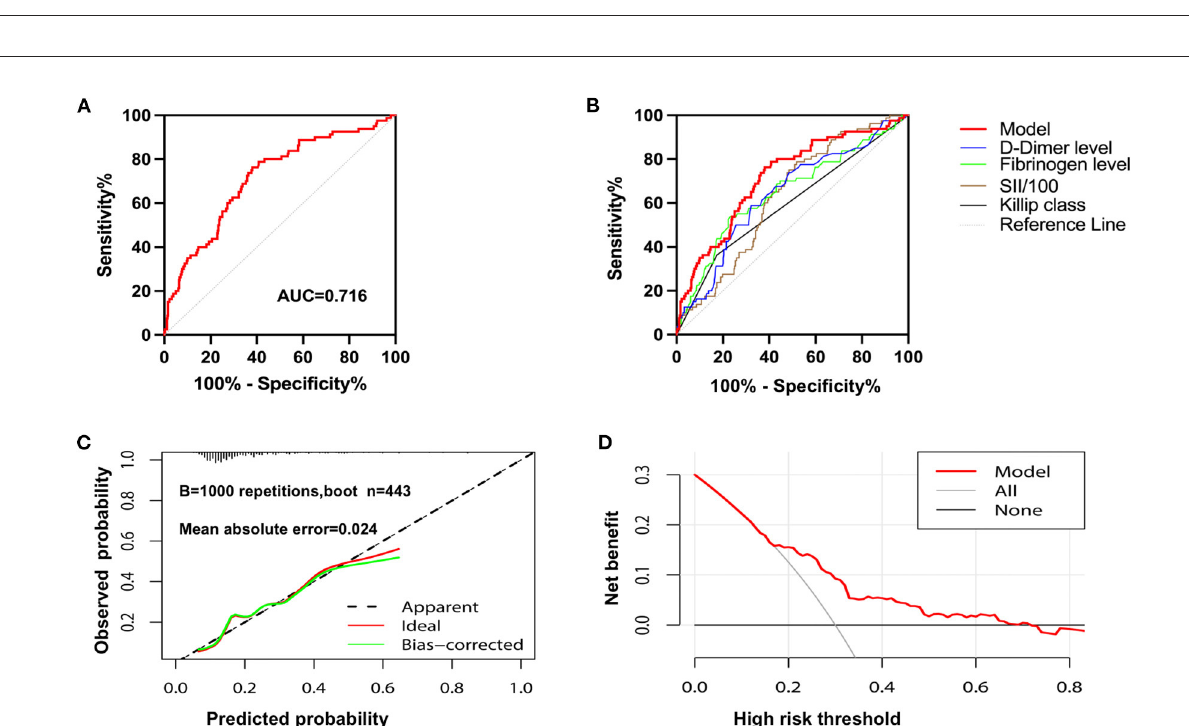
FIGURE3 The evaluation of the nomogram model. (A) Receiver operating characteristic curve for assessing the discrimination performance of the nomogram model. (B) Receiver operating characteristic curves of patients with no-reflow predicted by Killip class on admission, D-dimer, fibrinogen, SII/100 and nomogram model. (C) Calibration curve of nomogram model in predicting the risk of no-reflow. (D) The decision curve analysis of the nomogram model.